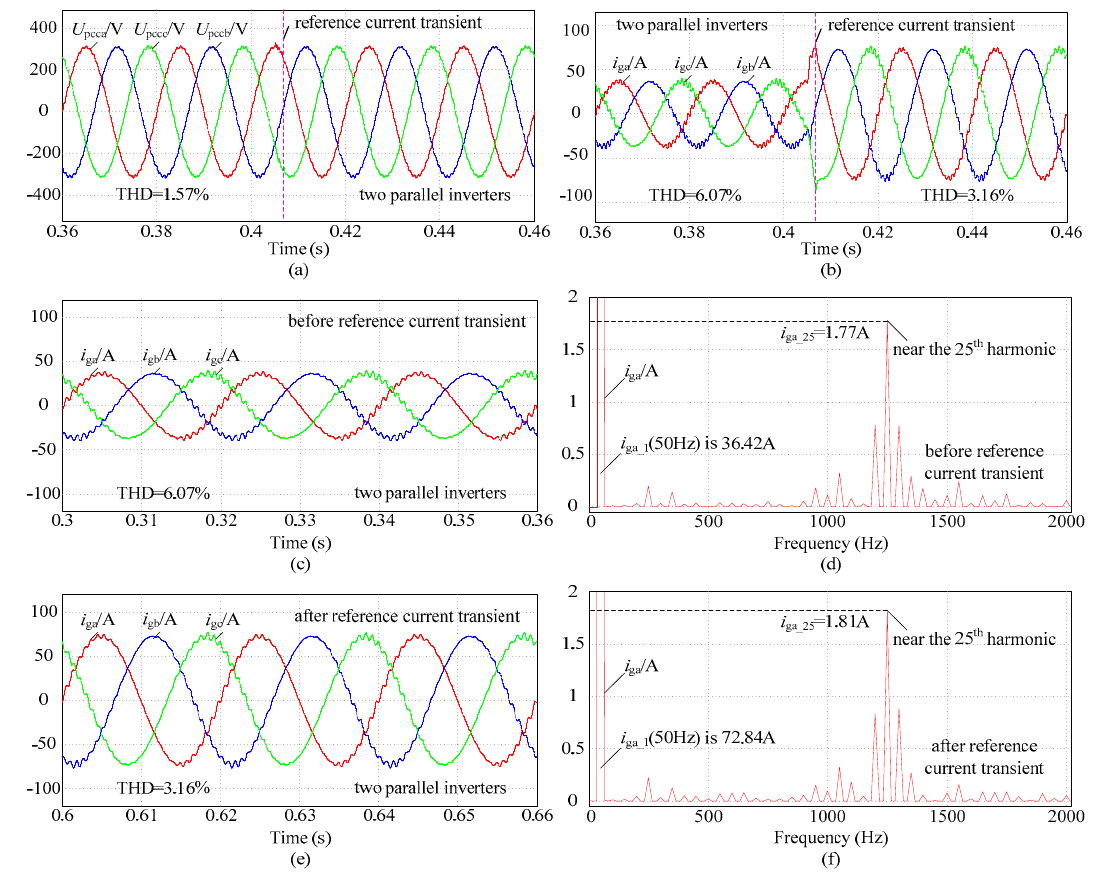
Figure 12. Simulation waveforms of point of common coupling (PCC) voltage u PCC and grid-connected current i g in case I during reference current transient (two parallel inverters). ( a ) PCC voltage u PCC ; ( b ) grid-connected current i g ; ( c ) grid-connected current i g (before); ( d ) spectrogram of grid-connected current i g (before); ( e ) grid-connected current i g (after); ( f ) spectrogram of grid-connected current i g (after).